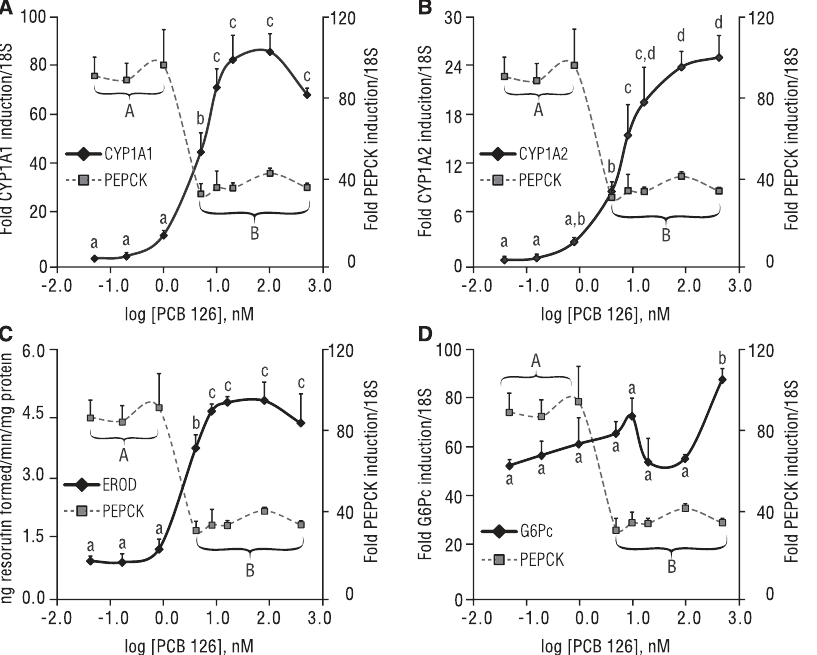
Figure 4. Interaction of CYP1A1, CYP1A2, EROD, and G6Pc versus PEPCK gene expression with PCB 126 dose-response. (A) EC 50 of PCB 126 for CYP1A1gene expression and suppression of forskolin induction of PEPCK gene expression closely correlate. (B) EC 50 of PCB 126 for CYP1A2 gene expression and suppression of forskolin induction of PEPCK gene expression are modestly correlated but demonstrate the expected directionality. (C) EC 50 of PCB 126 for EROD activity induction and suppression of forskolin induction of PEPCK gene expression closely correlate. (D) Forskolin-induced G6pc gene expression fails to demonstrate a clear relationship with dose-dependent effect of PCB 126 on forskolin-induced PEPCK gene expression. Tested concentrations of PCB 126 in base 10 format are: 0.05, 0.20 1.0, 5.0, 10.0, 20.0, 100.0, and 500.0. Alphabetical letters separate doses of PCB 126 that elicited significantly (p , 0.05) different degrees of response for the parameter designated on the left-hand y-axis (lowercase) or right-hand y-axis (uppercase). Data are average of 3 experiments; error bars are 2 / + SD.